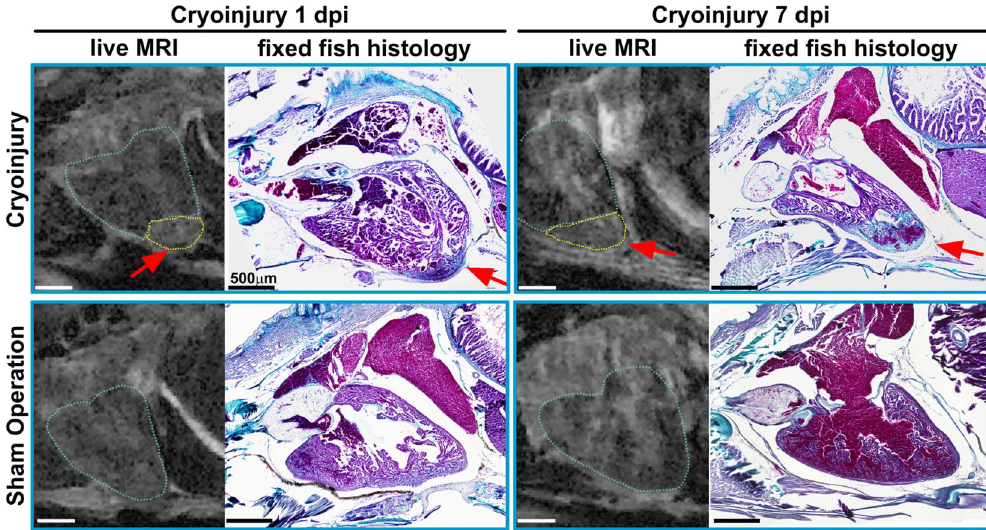
Figure 3. Confirming in vivo MRI with histology: MR images of the live ventricle in two cryo-injured (see arrows and outlined in yellow) and two sham operated wt fish at 1 and 7 days post injury and their corresponding histological sections. To confirm proper identification of the injury, the fish were sacrificed and fixed for histology within minutes after the in vivo scan. Trichrome staining was used to highlight the injured region in the same heart; collagen appears blue (highlighting the injury region) and cytoplasm pink. n = 2 per group. Scale bar 0.5